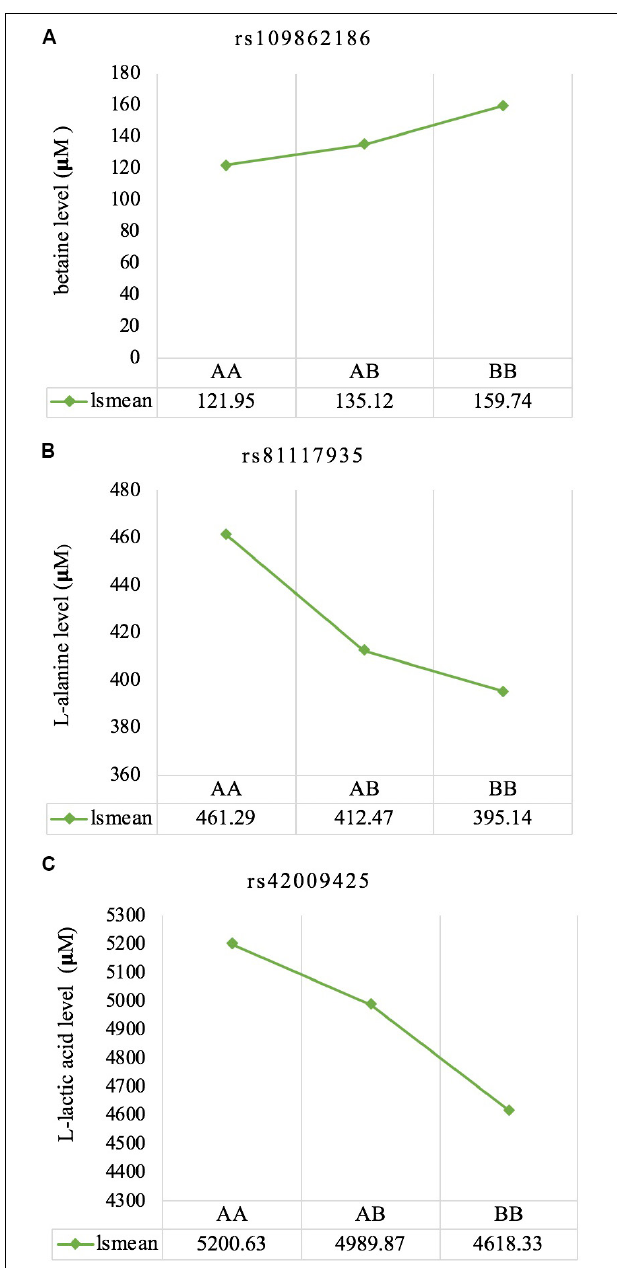
FIGURE 5 | Least square means for the genotypic classes of significant SNPs associated with betaine (A) , L -alanine (B) , and L -lactic acid (C) , respectively. All three significant SNPs (rs109862186, rs81117935, and rs42009425) showed characteristics of additivity with the associated